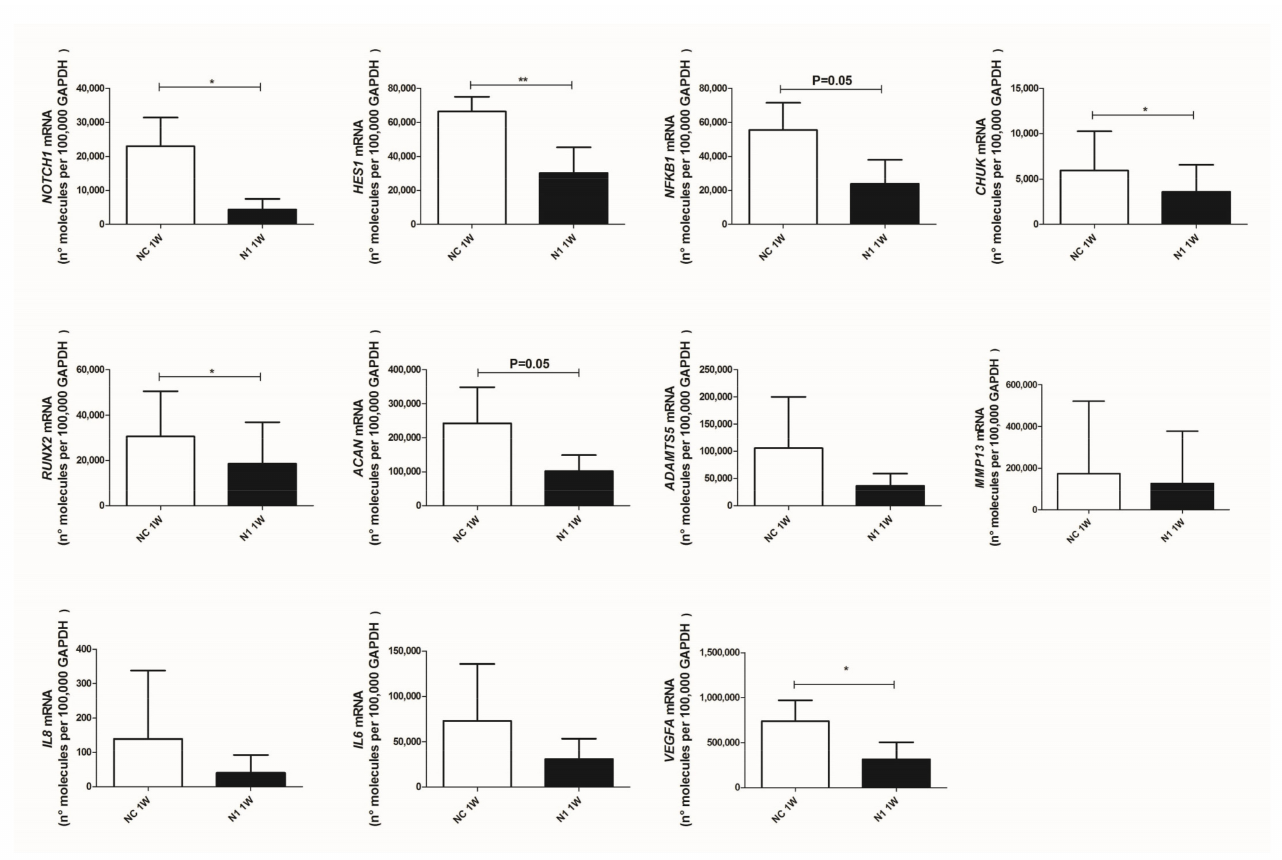
Figure 4. Effects of NOTCH1 silencing at the level of transcription of key genes in osteoarthritis. Total RNA was extracted from 1 week micromasses established with control (NC) or NOTCH1 silenced chondrocytes (N1). mRNA levels were calculated for each target gene and normalized using the reference housekeeping gene GAPDH according to the formula 2 - ∆ Ct and expressed as number of molecules per 100,000 GAPDH molecules; * p < 0.05, ** p <